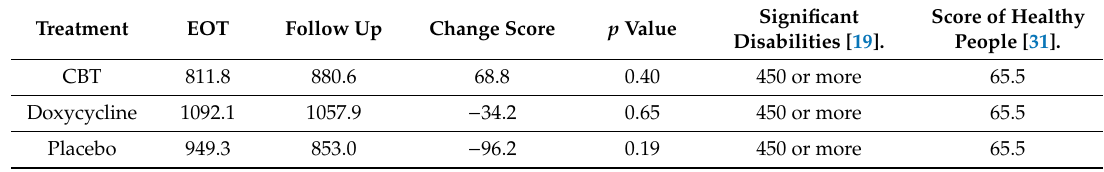
Table 4. Mean functional impairment scores at end of treatment and follow-up.